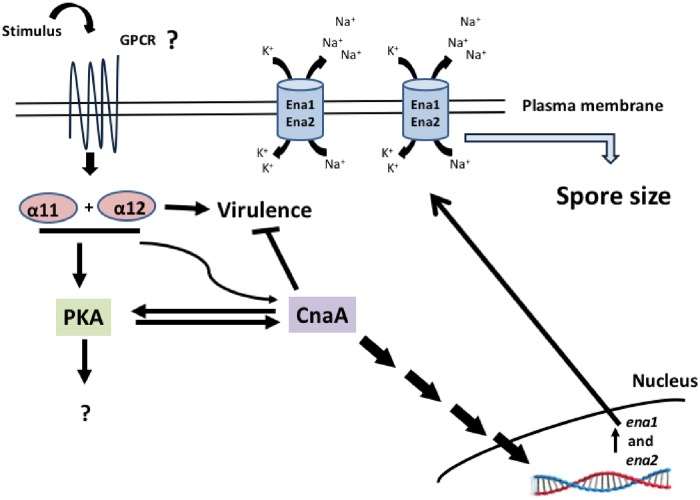
Proposed model of the function of Gpa11 and Gpa12 regulating sporangiospore size and virulence in M. circinelloides.Through one or more GPCRs, Gpa11 and Gpa12 in the spores of M. circinelloides activate CnaA, which in turn activates the calcineurin pathway. The calcineurin pathway leads to the expression of genes regulated by this pathway, like ena1 and ena2. The dysfunction of Ena1 and Ena2, which are Na+-K+ ATPases, could increase cytosolic levels of sodium ions, allowing the influx of water, leading to an increase in spore size in M. circinelloides as was observed in the Δgpa11/Δgpa12 strain. The CnaA negatively regulates the virulence and stimulates the PKA pathway, meanwhile Gpa11 or Gpa12 positively regulate the virulence and activate the PKA pathway during aerobic germination, but unknown elements are implied in the avirulent phenotype by the mutations in gpa11 and gpa12.